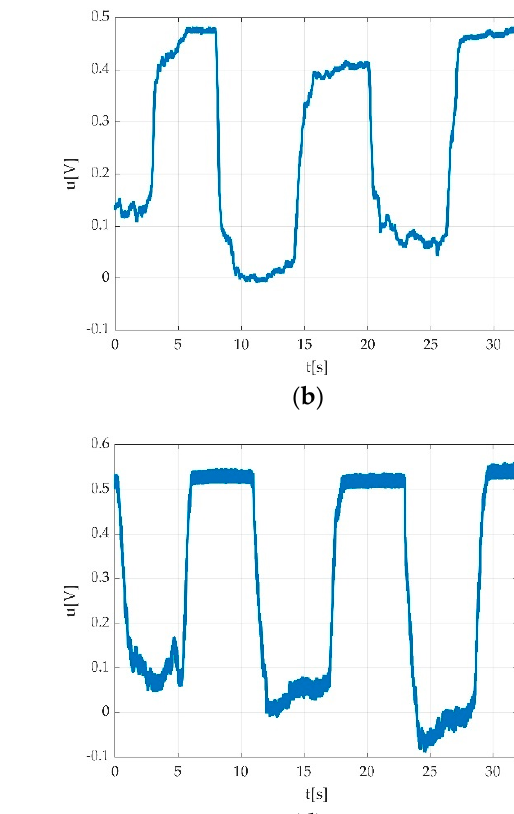
Figure 18. Example of errors due participant delay in contractions the muscle on tester command: